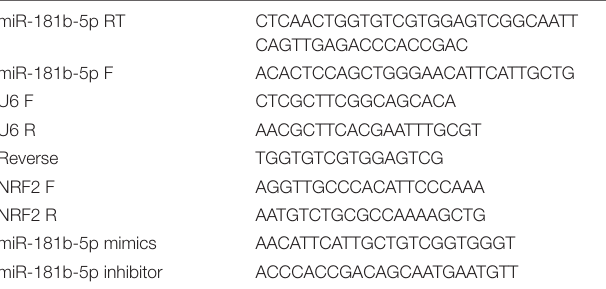
TABLE 1 | Primers sequences used in this